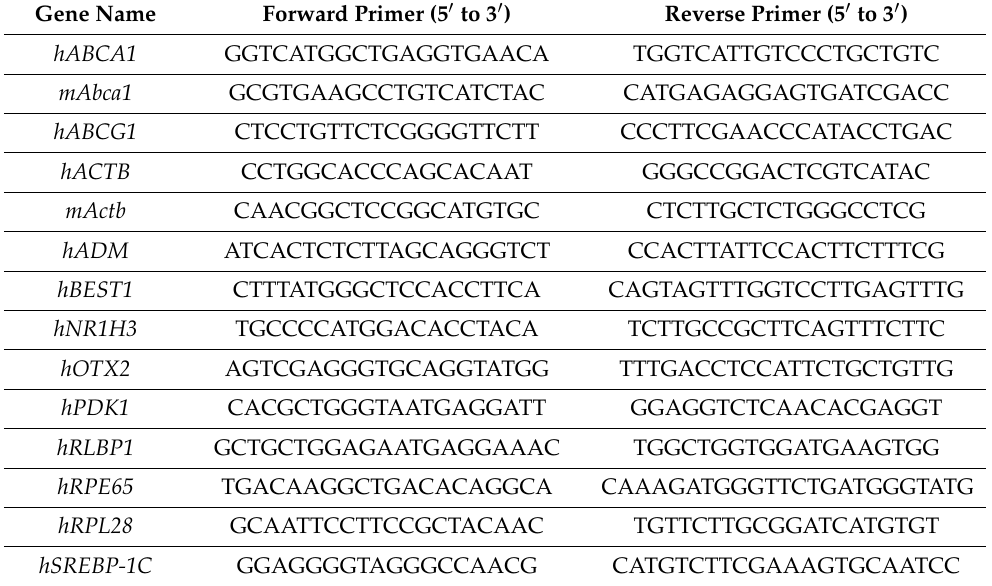
Table 2. Primer pairs for the amplification of cDNA derived from humans (h) or mouse